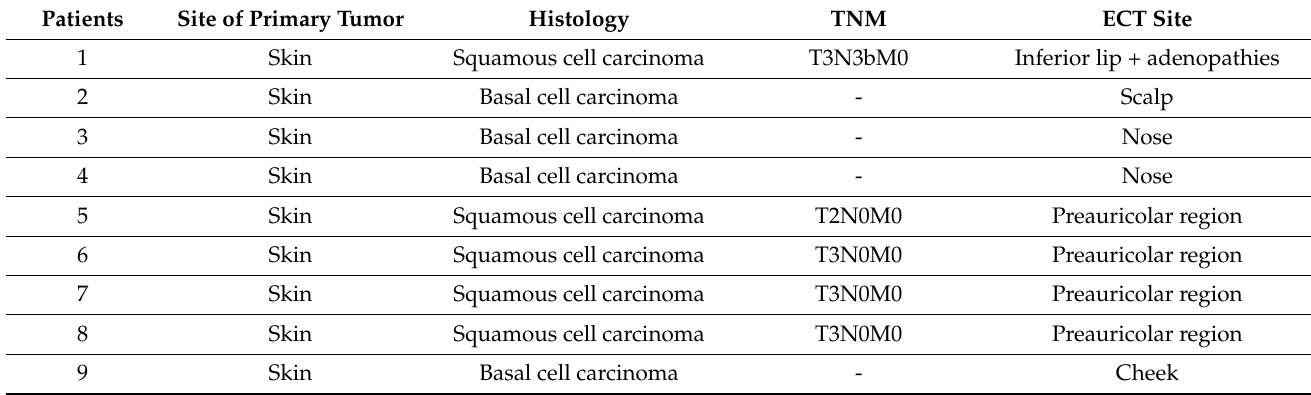
Table 2. Histology, TNM stage and site of electrochemotherapy (ECT) of the whole cohort (27 patients). Tumor size for basal cell carcinomas was between 3 and 5 cm. Patients Site of Primary